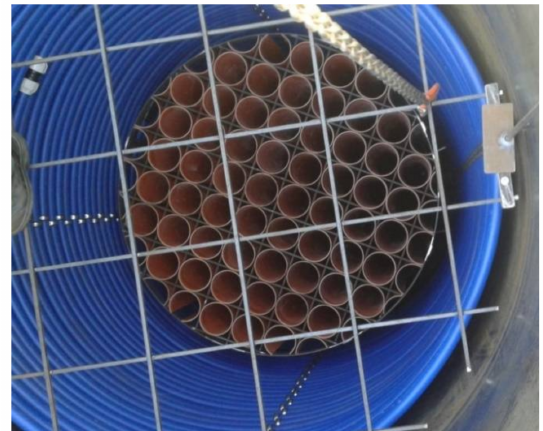
Figure 3. Skeletal bed situated in the fermenter, secured with a grid; between the bed and the wall of the fermentor there is a coil-view (photo by Grzegorz